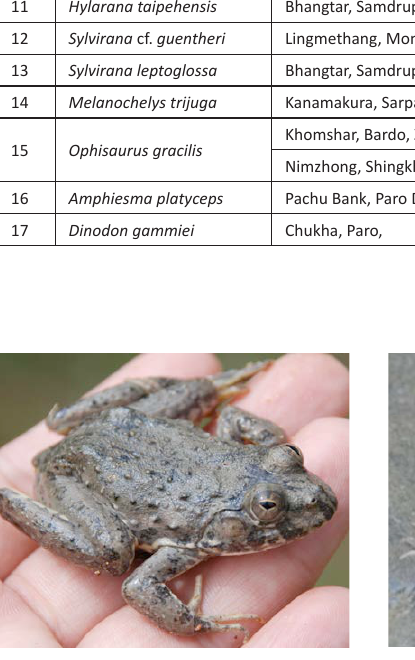
Image 1. Euphlyctis cyanophlyctis from Tshangkha, Dagana. © Jigme Tshelthrim